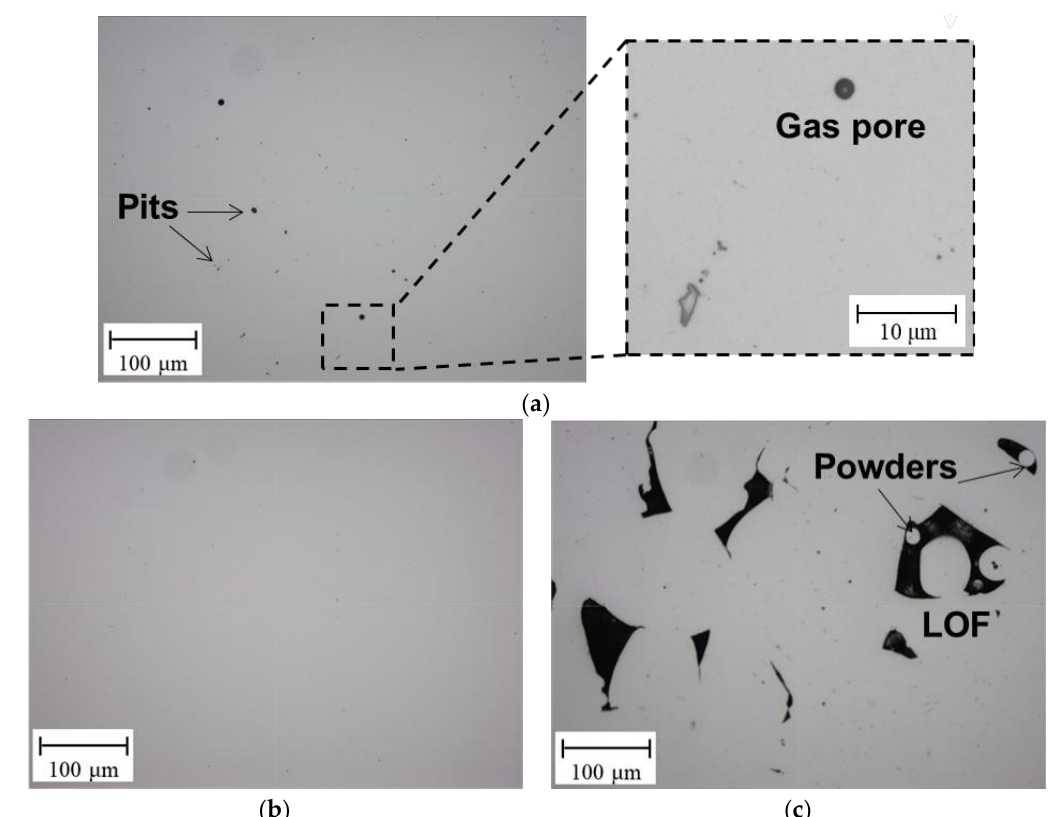
Figure 5. OM images obtained using an optical microscope for the ( a ) 0.6 m/s, ( b ) 1.0 m/s, and ( c ) 1.4 m/s LBS conditions.